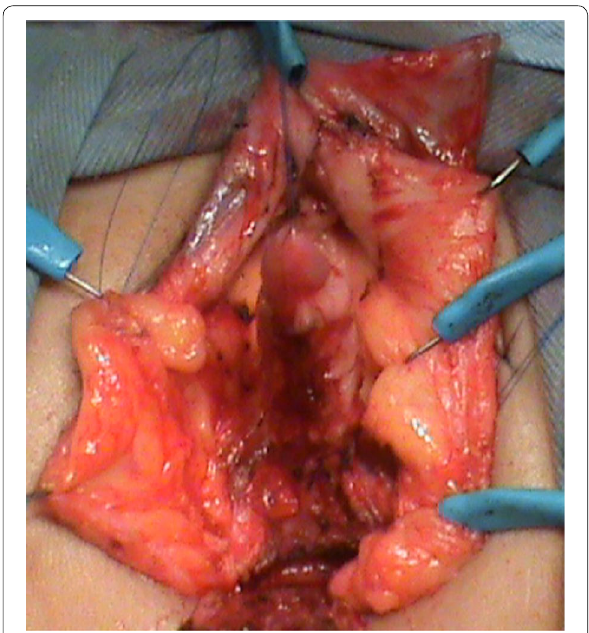
Fig. 1 The clitoris is fully degloved till the penopubic